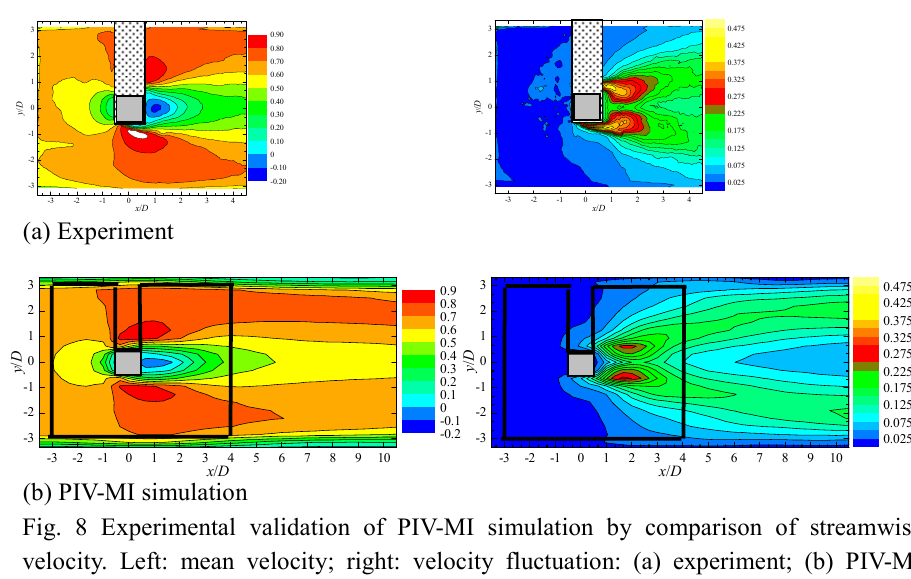
Fig. 8 Experimental validation of PIV-MI simulation by comparison of streamwise velocity. Left: mean velocity; right: velocity fluctuation: (a) experiment; (b) PIV-MI